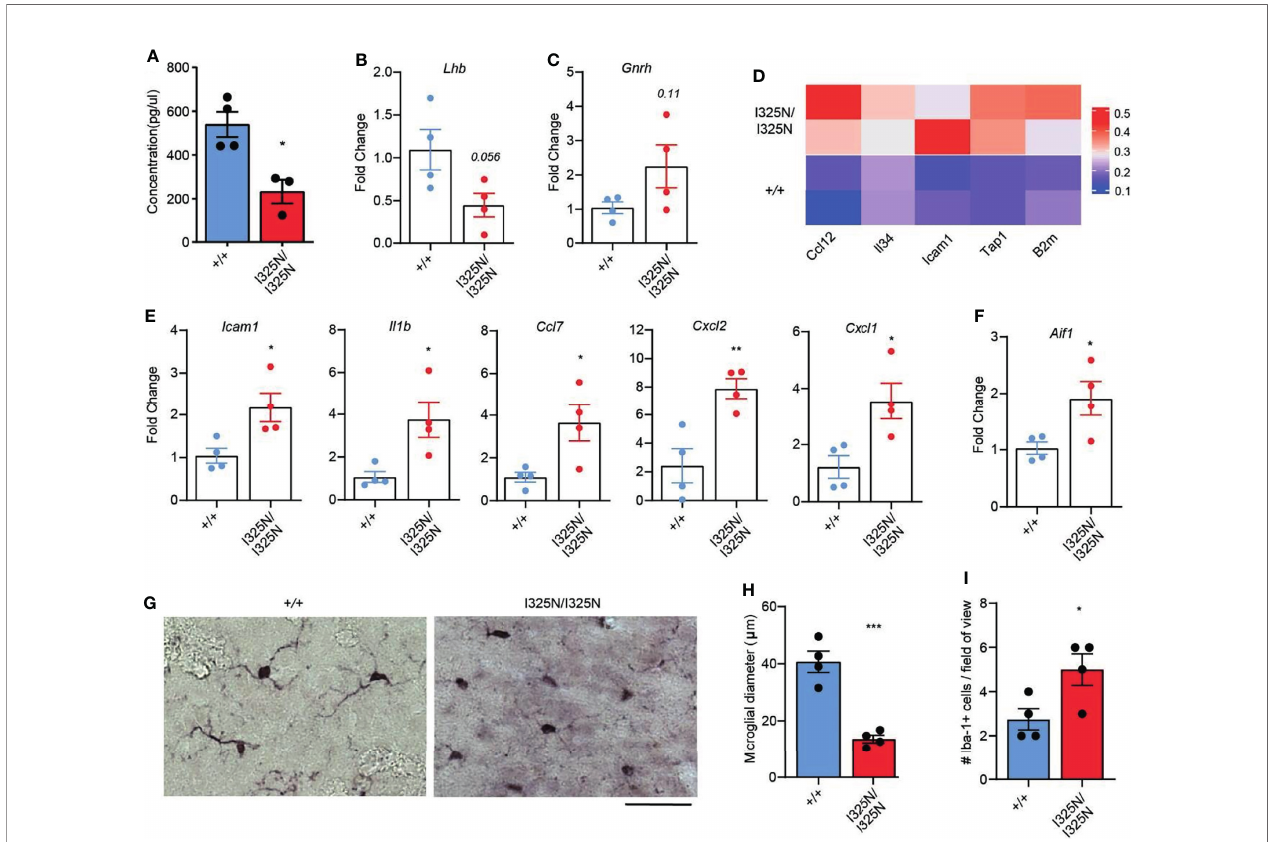
FIGURE 4 | Tnfaip3 I325N mice exhibit reduced serum luteinizing hormone and spontaneous CNS in fl ammation. (A) ELISA for luteinizing hormone from serum plasma from Tnfap3 I325N littermates of indicated genotypes, and (B) RTPCR analysis of brain lysates obtained from dissected pituitary and hypothalamus for luteinizing hormone or (C) gonadotropin-releasing hormone mRNA. (D) Visium transcriptomic analysis of preoptic area (PO) of Tnfaip3 I325N littermates of indicated genotypes revealed an upregulation of microglial associated genes at steady state. Each row represents data from an individual mouse. (E) RTPCR analysis of brain lysates from dissected pituitary and hypothalamus for microglial-associated in fl ammatory markers from Tnfaip3 I325N littermates, and for (F) the microglial marker AIF1 that encodes Iba-1. (G) Representative immunohistochemistry images for Iba-1 from Tnfaip3 I325N littermates of indicated genotypes showing a more rami fi ed phenotype in Tnfaip3 homozygotes. Scale bar = 20 µm. (H) Quanti fi cation of microglial diameter and (I) number of Iba-1+ cells per fi eld of view from (F) . Error bars represent s.e.m and Student ’ s T test used for signi fi cance analysis * = P < 0.05; ** = P < 0.01; *** = P <